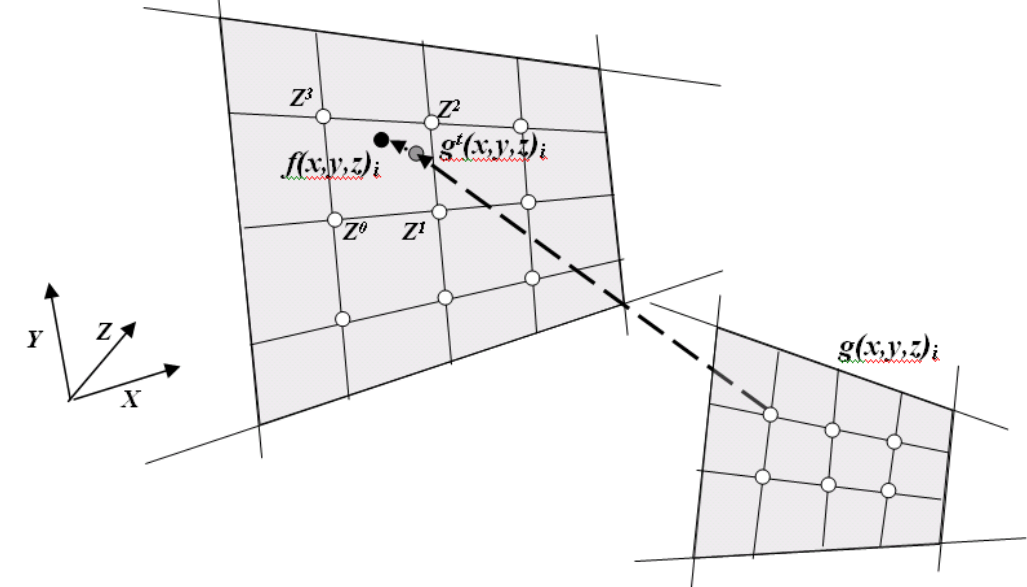
depicts the i i